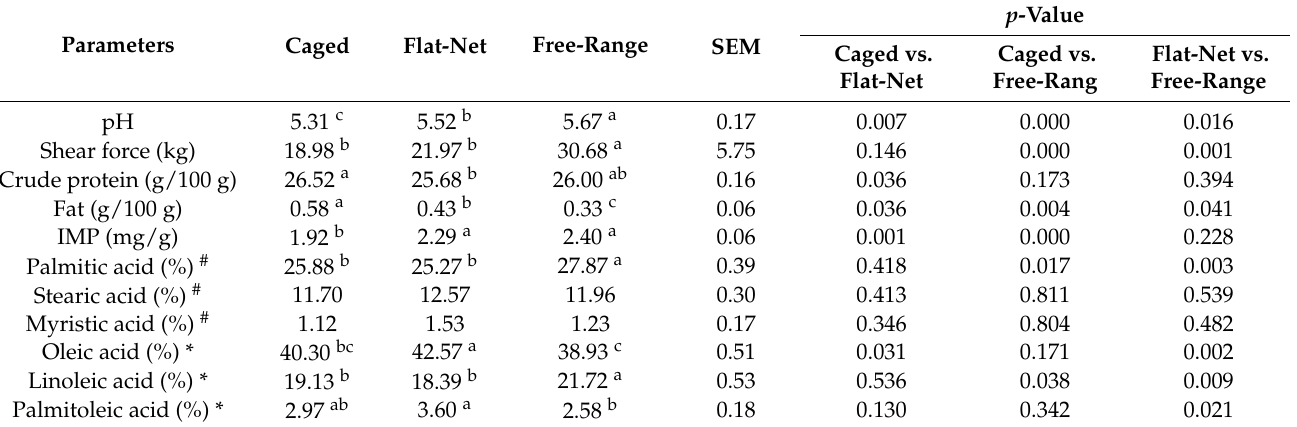
Table 2. Meat quality parameters measured under three rearing systems of Lueyang black-bone